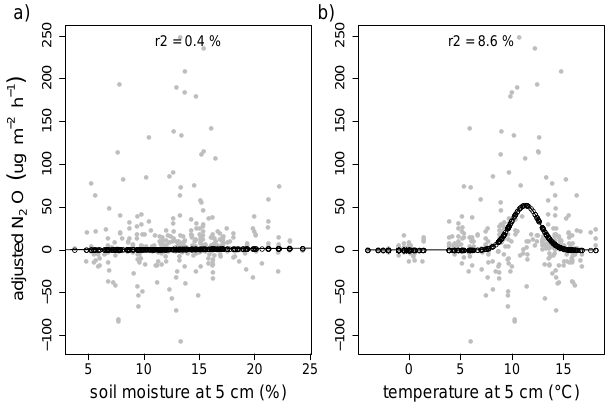
Figure 7. Sensitivity of forest floor N 2 O fluxes (µgm − 2 h − 1 ) of forest/mire types together with environmental factors: (a) N 2 O flux response to soil moisture at 5cm, and (b) N 2 O flux response to soil temperature at 5cm during the period including wet, typical, and dry years. The N 2 O flux response form to each individual environ- mental factor is illustrated so that the simulated value by Eq. (4) for each data point was recalculated by allowing only one factor at a time to vary, while the other was set to its mean level. To the ad- justed N 2 O flux responses (black points) the corresponding residual of each data point was added in order to describe the unexplained model variation (gray points). The r 2 (%) is the proportion of ex- plained variance.